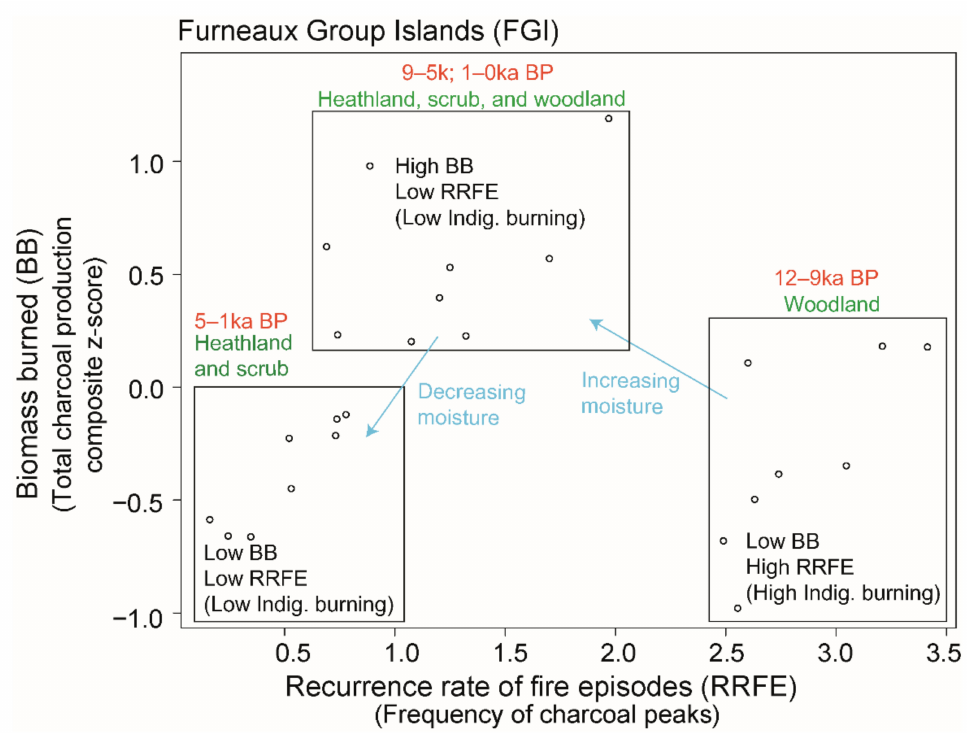
Figure 3. Scatter plot showing a non-linear relationship between RRFE and BB on the FGI during the Holocene in relation to changes in climate and Indigenous (Indig.) land use. Each point represents a 500-year period relationship between BB (total charcoal production) and RRFE (frequency of charcoal